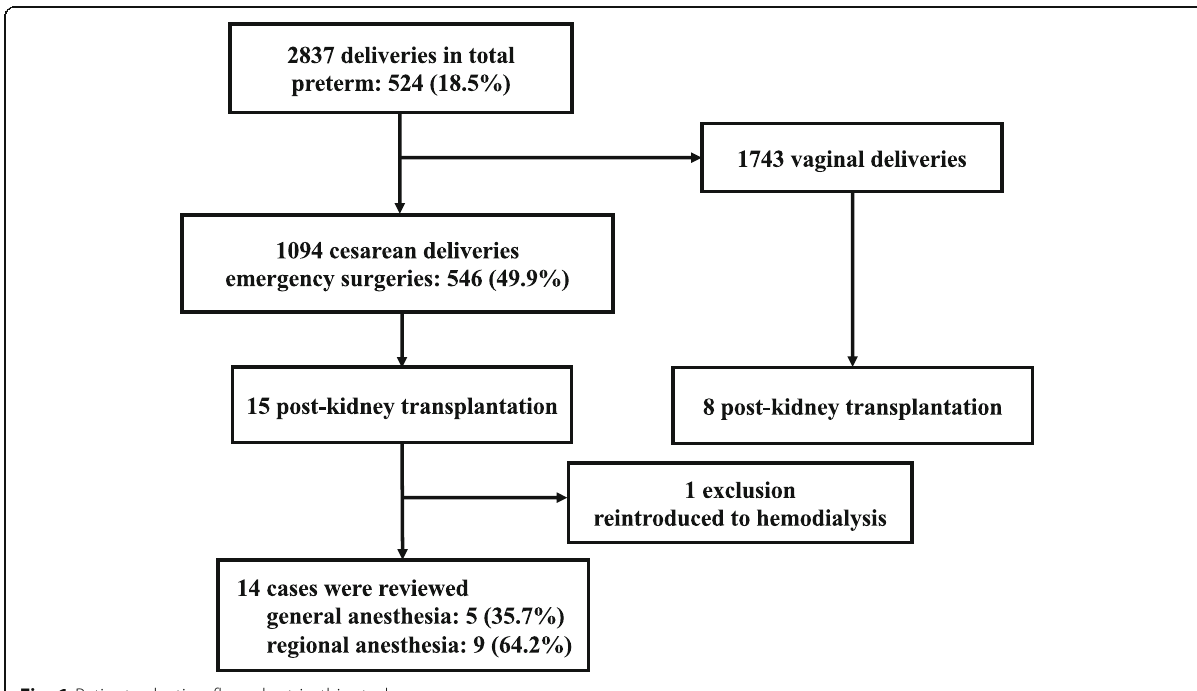
Fig. 1 Patient selection flow chart in this